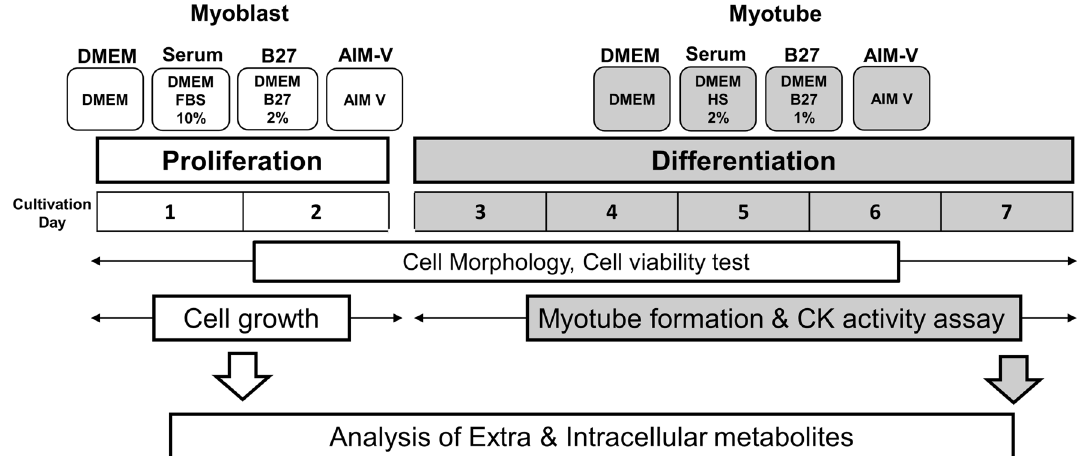
Figure 1. The experimental schematic workflow in this study. C2C12 cells were cultured for 7 days in the following 4 different types of mediums. (i) DMEM; only basic medium without any supplementation, (ii) Serum; DMEM supplemented with animal-derived serum. 10% of fetal bovine serum (FBS) and 2% of horse serum (HS) were used for proliferation and differentiation, respectively. (iii) B27; chemically defined serum substitute, 2% and 1% of B27 were supplemented in DMEM for proliferation and differentiation, respectively. (iv) AIM-V, chemically defined medium. Cell morphology and viability were monitored for the entire culture period. Cell growth was further profiled during the proliferation status, CK activity, myotube diameter, muscle contraction were further assessed for myogenic differentiation. Finally, culture samples from day 1 and day 7 representing myoblasts and myotubes were analyzed for the metabolomic